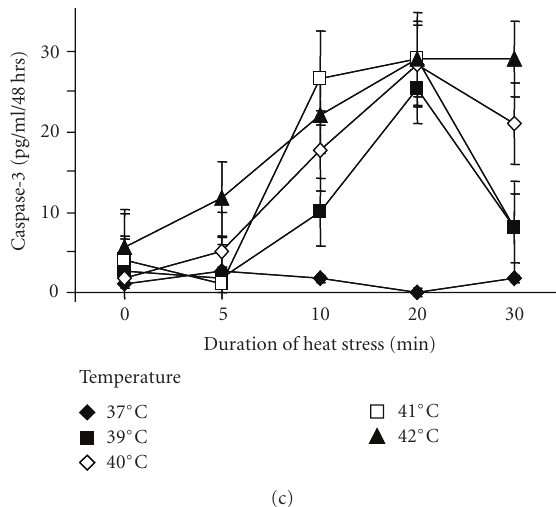
Figure 5: Hsp40/70 rescue cells from heat stress. (a) Cells were pre-incubated with 5 or 10nM of Hsp40 siRNA and then exposed to increasing heat stress (39–42 ◦ C) for 20 minutes. Following cells were kept under normal growth conditions for 48 hours and viable cells were counted after trypan blue exclusion staining. (b) Cells were pre-incubated with 5 or 10 nM of Hsp70 siRNA and treated as described above “a”. Data points represent the mean ± S.E.M. of triplicate experiments. ∗ indicates P < . 01 compared to control (student’s paired t - test, two-tailed). (c) Expression of caspase-3 by PDMM treated for various time intervals with increasing temperatures. Data points represent the mean ± S.E.M. of triplicate